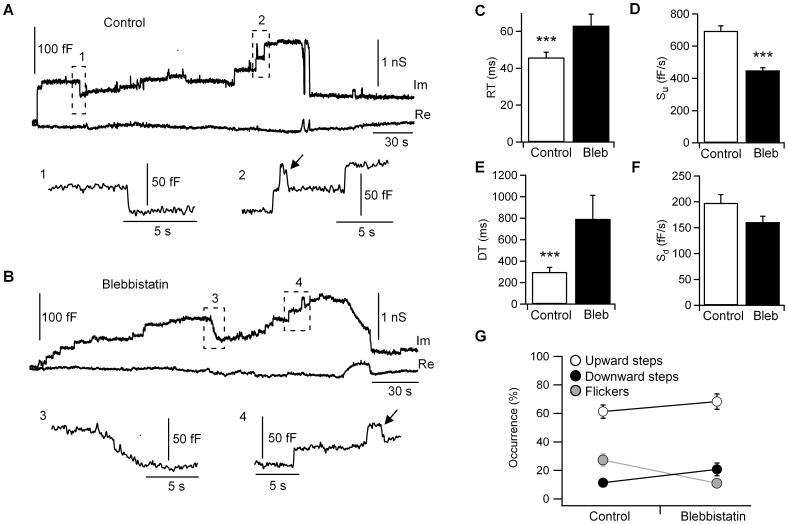
Inhibition of NM-2 activity through acute blebbistatin treatment slows the kinetics of exocytosis and endocytosis.Representative traces of capacitance steps from a control (A) and blebbistatin-treated cell (B). Re and Im represent the real and imaginary parts, respectively, of the admittance change. The steps labelled 1–4 at higher magnification show single downward steps, upwards steps and capacitance flickers (arrows). The kinetic parameters of the capacitance steps demonstrate that blebbistatin treatment affects the rise time (C) and upward-slope (D) to prolong the duration of the exocytic event. Blebbistatin also produces a increase in the decay time (E) without significantly affecting the downward-slope (F). The proportion of capacitance flickers (reversible fusion) decreased in blebbistatin-treated cells versus control cells (G) (p<0.05). Error bars, S.E.M. ***p<0.01.